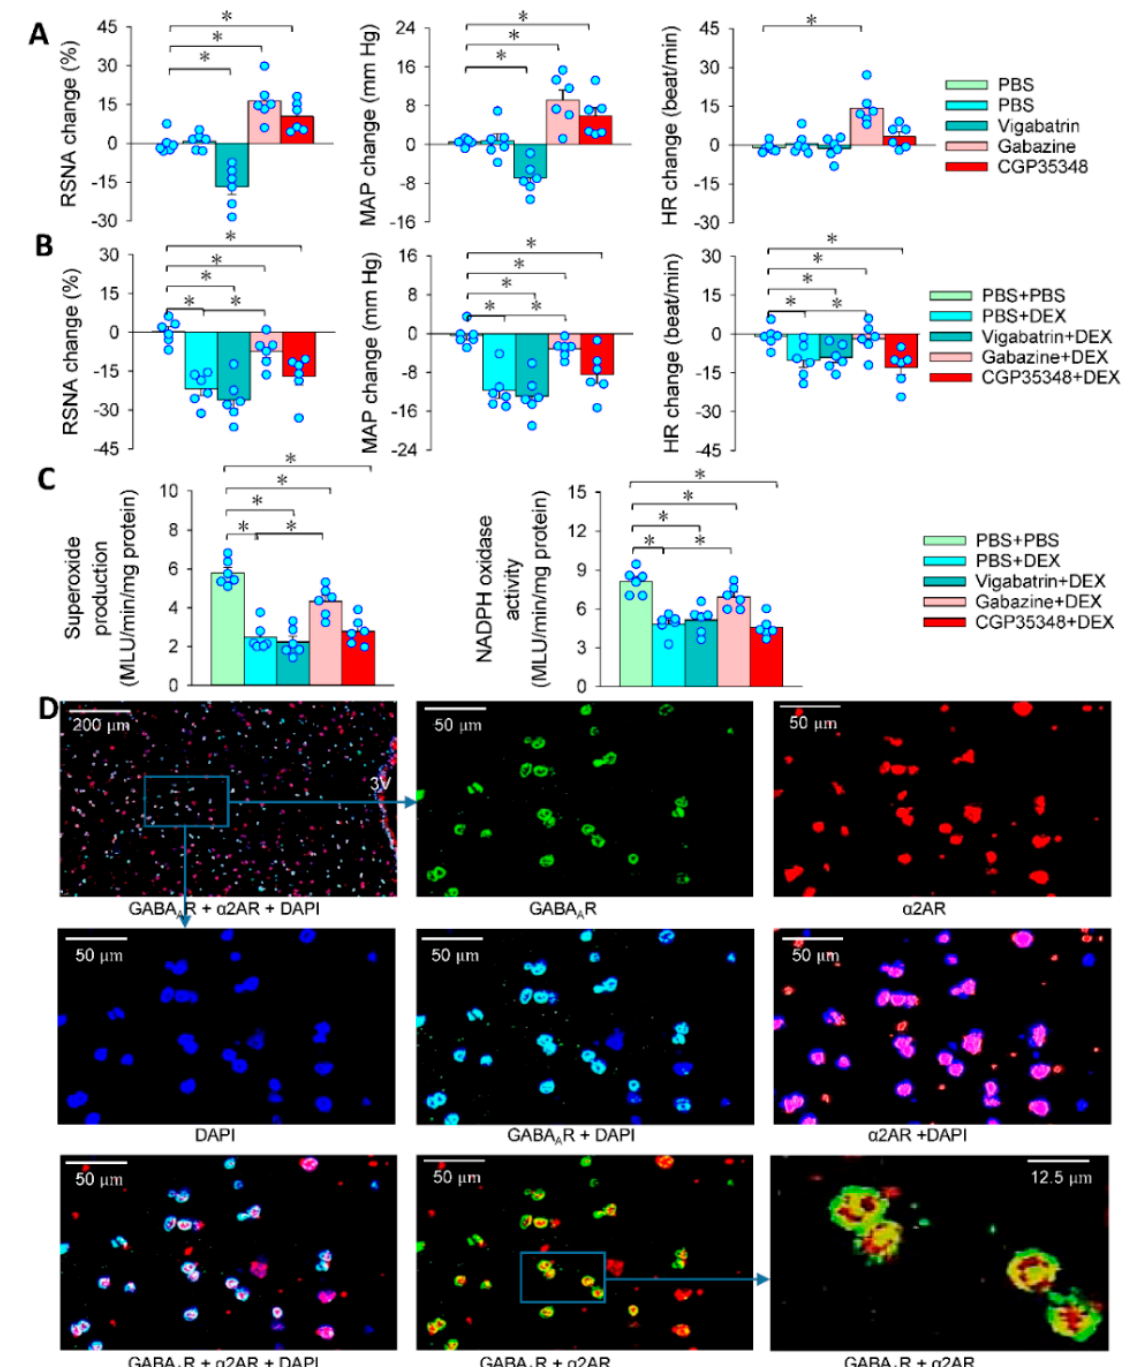
Figure 6. GABA in the effects of DEX in the LPS-treated rats. PVN microinjection was carried out 24 h after the intraperitoneal injection of LPS. ( A ) Effects of PVN microinjection of vigabatrin (a GABA transaminase enzyme inhibitor, 10 nmol), gabazine (a GABA A receptor antagonist, 0.1 nmol) or CGP35348 (a GABA B receptor antagonist, 10 nmol) on RSNA, MAP and HR; ( B ) effects of pretreatment with vigabatrin, gabazine or CGP35348 on the roles of DEX in reducing RSNA, MAP and HR in LPS-treated rats; ( C ) effects of pretreatment with vigabatrin, gabazine or CGP35348 on the roles of DEX in superoxide production and NADPH oxidase activity in LPS-treated rats (pretreatment was carried out 10 min before administration of DEX); ( D ) immunofluorescent staining for α 2A receptors (red), GABA A receptors (green) in the PVN. Nuclei were stained with DAPI (blue). Abbreviation: 3V, the third ventricle. * p < 0.05. n = 6.